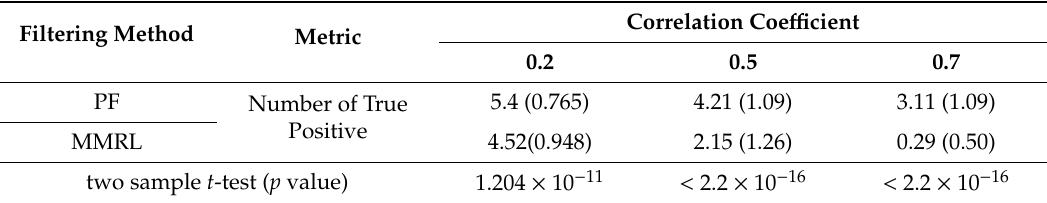
Table 1. An average number of true positives from the proposed PF and MMLR with SIS and a significance level of paired two-sample t -test for the mean di ff erence of the number of true positives between two methods using the number of true positives obtained over 100